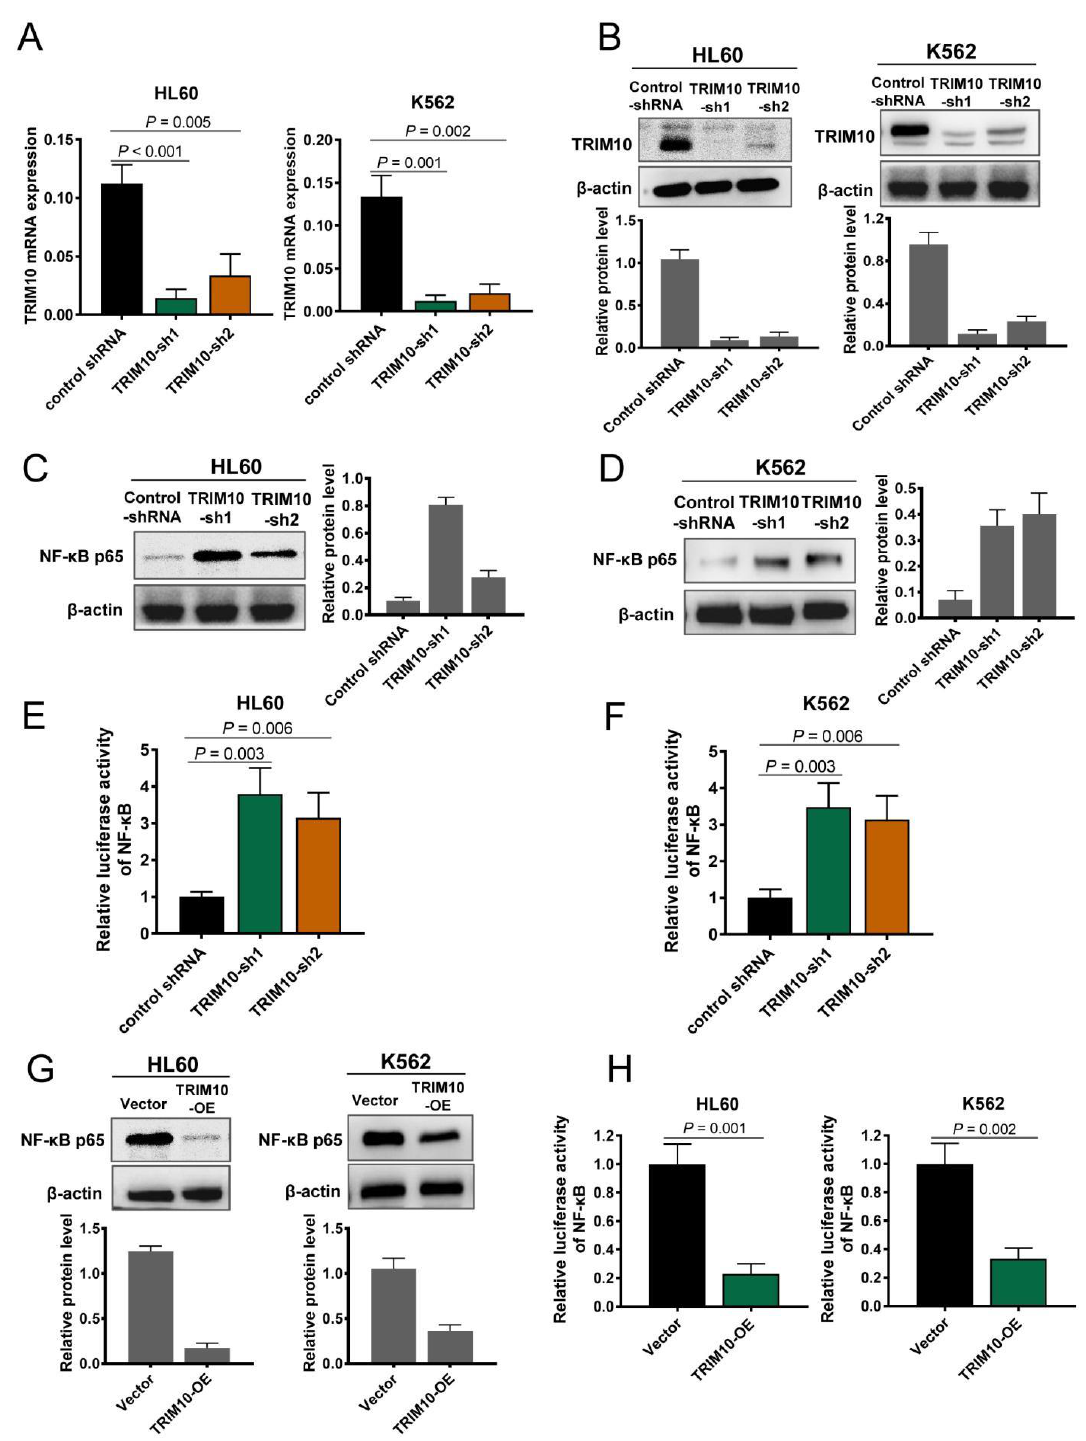
Figure 4. TRIM10 downregulation activates the NF- κ B signaling pathway in AML cells. ( A , B ) qRT-PCR and Western blots confirmed that TRIM10 expression was significantly decreased by TRIM10-shRNA1 or shRNA2 in the HL60 and K562 AML cell lines. ( C , D ) Western blot analysis of the expression levels of NF- κ B p65 proteins in TRIM10-shRNA1, shRNA2 or the control shRNA in the HL60 and K562 AML cell lines. ( E , F ) Luciferase reporter analysis of transcriptional activity of NF- κ B. The luciferase activity was expressed as a fold of HL60 or K562 control shRNA, with 1 being the value for controls. ( G , H ) Western blot and luciferase reporter analysis of protein level (left) and transcriptional activity (right) of NF- κ B,